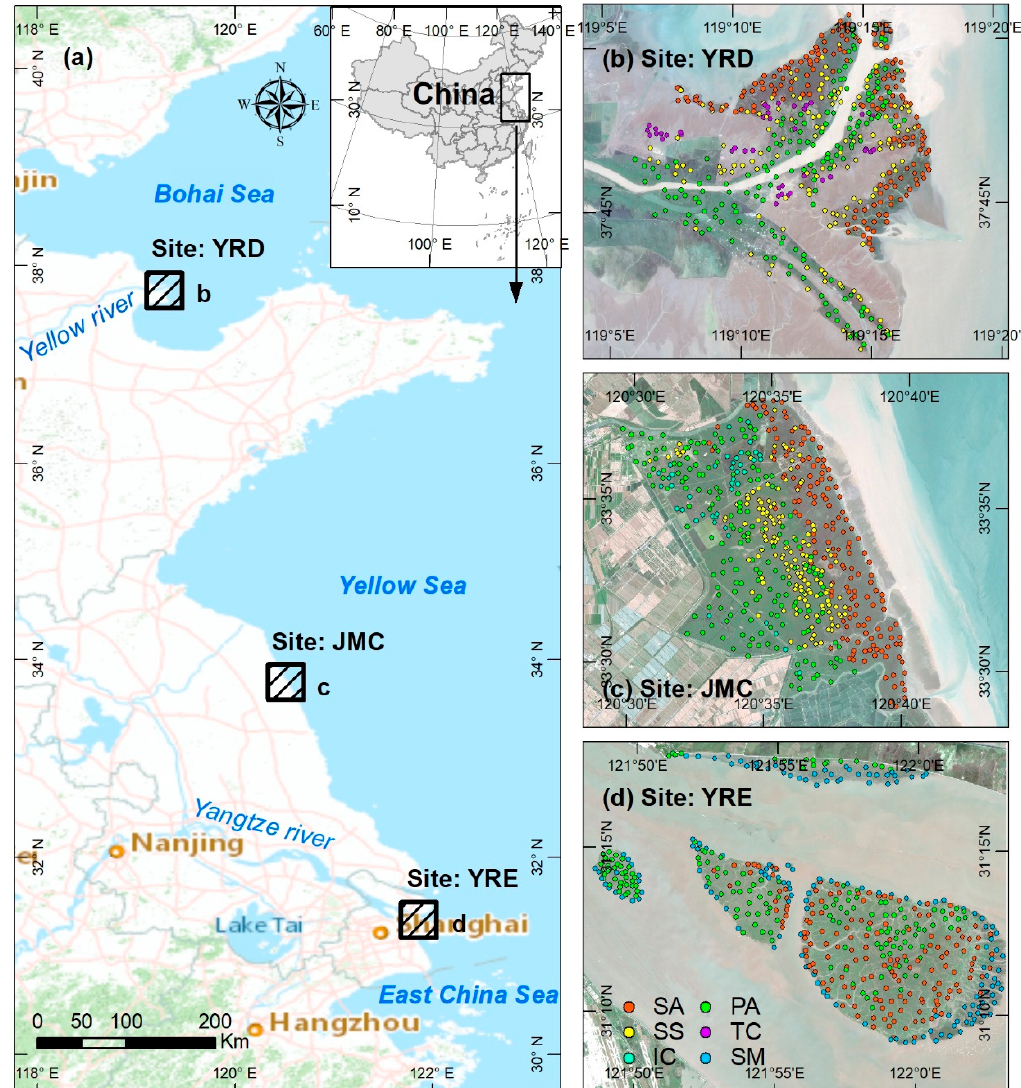
Figure 1. ( a ) Location map showing the three study sites, the Yellow River Delta (YRD), Jiangsu Middle Coast (JMC), and Yangtze River Estuary (YRE); ( b – d ) enlarged Sentinel-2 images of each study area highlighting the distribution of six dominant salt marsh vegetation samples in the YRD, JMC, and YRE. Note: SA = S. alterniflora , PA = P. australis , SS = S. salsa , TC = T. chinensis , IC = I. cylindrica , and SM = S. mariqueter .